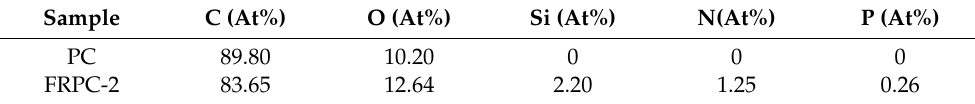
Figure 5. XPS survey spectra ( a ), C1s ( b ) and O1s ( c ) of PC and FRPC-2; Si2p ( d ) spectra of FRPC-2. Table 4. The elemental contents of the residues of PC and FRPC-2 after CCT.